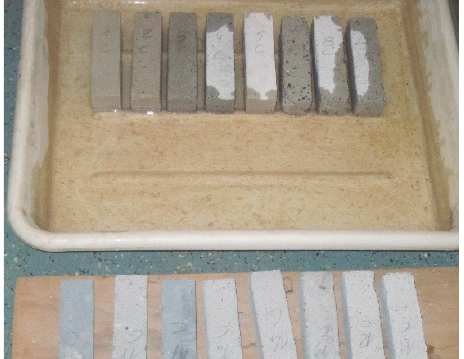
Figure 12. Study of the absorption caused by capillary rising of modified sand–lime products. All samples with the modifier admixed absorbed water evenly and gradually (the samples were placed in a vessel with water with the facing surface). Modified